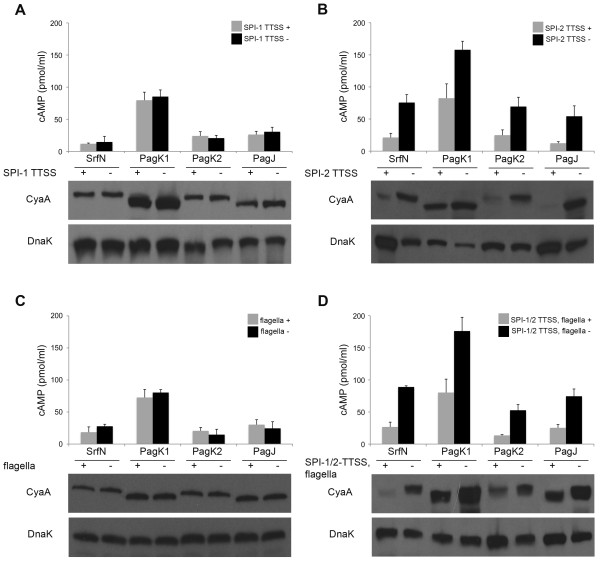
Translocation of SrfN and PagK1/PagK2/PagJ independent of SPI-1/2 T3SSs and flagella system. Genes of invA, ssaK, and flgB were deleted individually or in combination to block SPI-1 T3SS (A), SPI-2 T3SS (B), flagella system (C), or all three secretion machineries (D), respectively in Salmonella strains expressing CyaA'-tagged SrfN, or PagK1/PagK2/PagJ. Macrophage cells infected with Salmonella were lysed at 18 h post-infection to examine translocation and expression levels of SrfN and PagJ/K1/K2. Translocation of CyaA' fusions into the macrophage cytosol was measured using cAMP assay (top graphic figures) and the intracellular expression levels of CyaA'-tagged proteins were compared in parallel using Western blot analysis (bottom gel figures). DnaK levels were measured to normalize protein amounts loaded between lanes in Western blotting. Salmonella without SPI-2 T3SS was attenuated in intracellular growth and exhibited low DnaK levels compared with wild-type Salmonella.